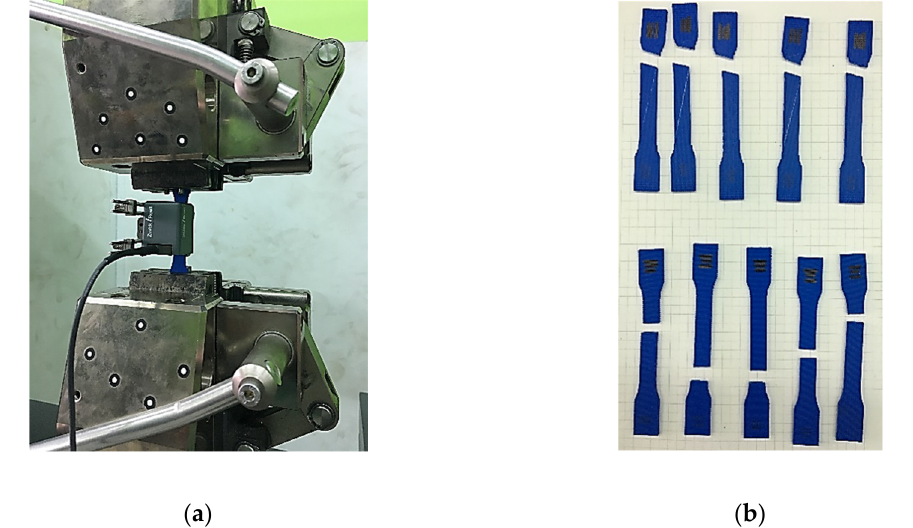
Figure 2. ( a ) View of the sample with the extensometer on the test stand. ( b ) A set of samples with longitudinal and transversal fiber orientations after completion of the test.